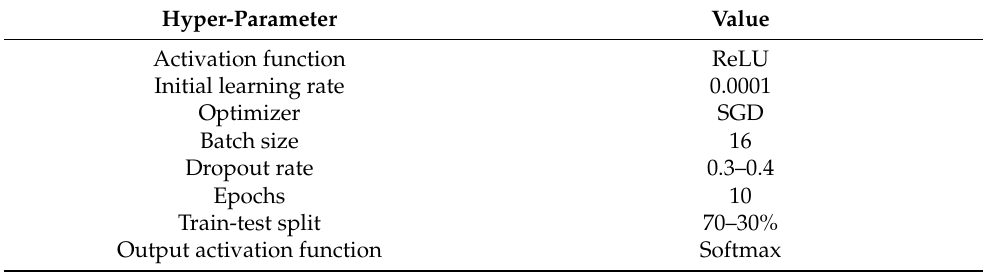
Table 3. Hyper-parameter values for training the TL